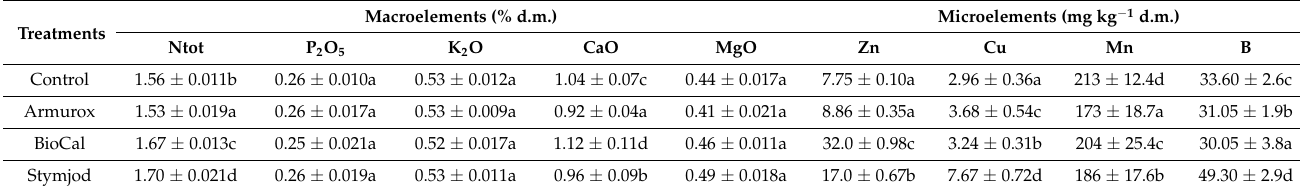
Table 3. The content of macro- and microelements of highbush blueberry leaves in 2021.